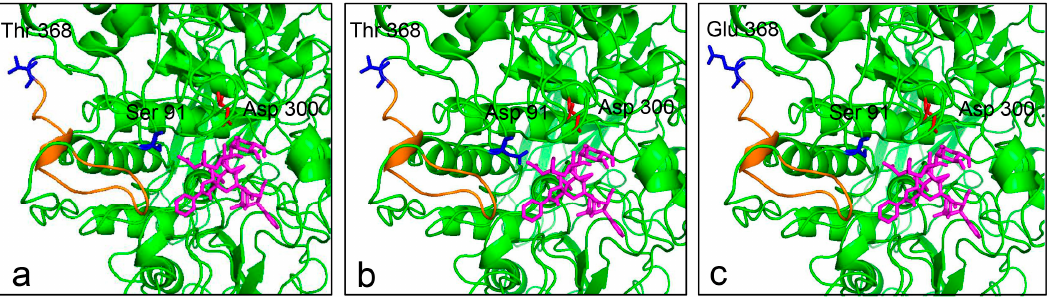
Figure 5. Molecular docking of wild type and mutants with XDT. XDT is shown in magenta. The nucleophile Asp 300 is colored in red. The side chains of Ser 91 /Asp 91 and Thr 368 /Glu 368 are shown in blue. ( a ) Side view of LXYL-P1–2 with XDT, showing Ser 91 and Thr 368 ; ( b ) Side view of EP1 with XDT, in which Ser 91 is replaced by Asp 91 ; ( c ) Side view of EP2 with XDT, in which Thr 368 is replaced by Glu 368 . The alteration of the loop near the active pocket is indicated in orange.